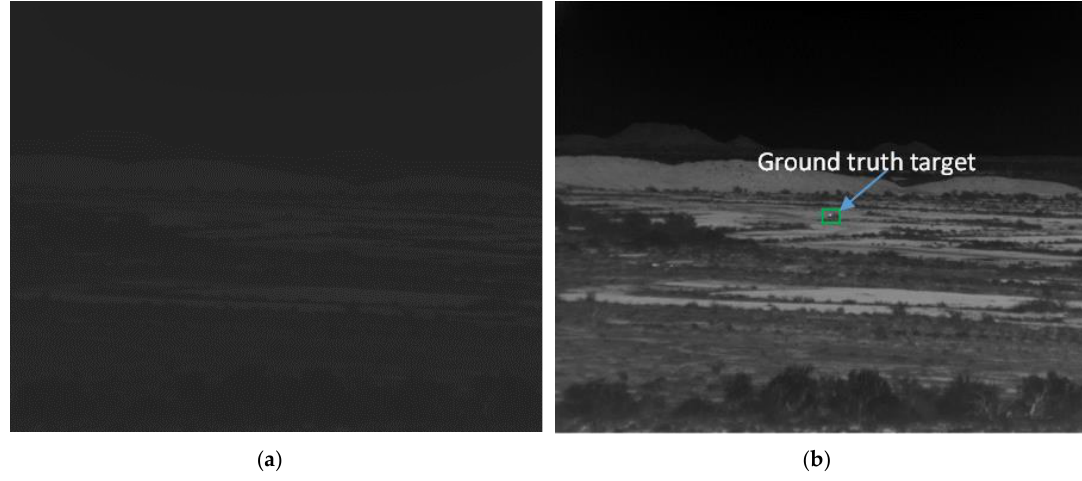
Figure A4. Before and after comparison of Approach 3. ( a ) Raw image; ( b ) Contrast-enhanced image.